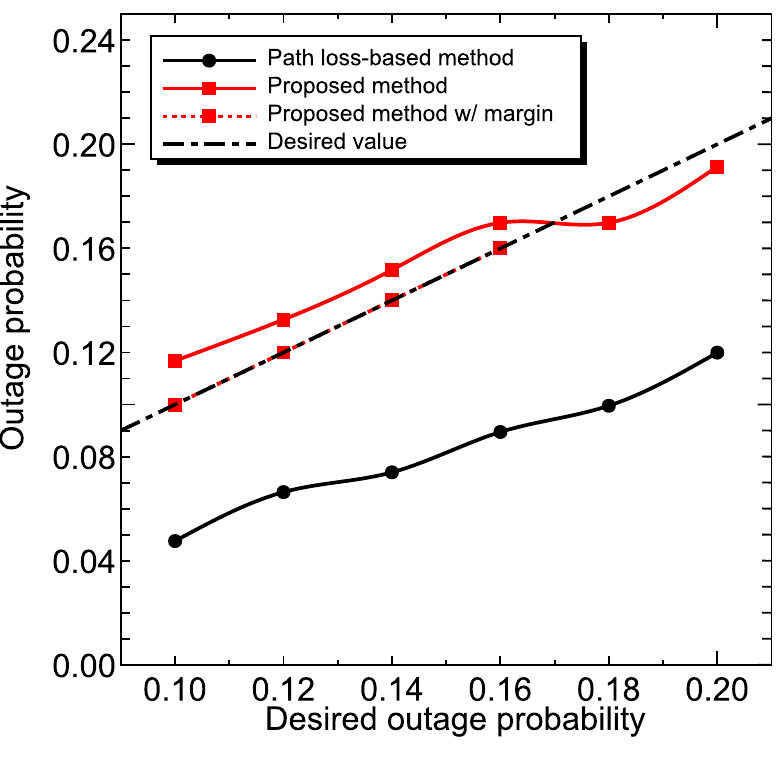
Figure 11. Outage probability characteristics after power control.